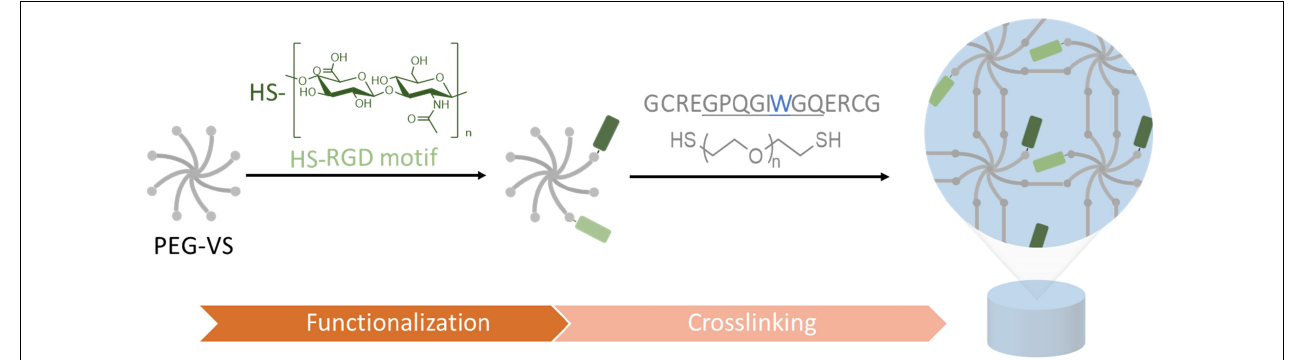
Figure 1 | Schematic illustration of PEG/GAG hydrogel formation. Branched 8-arm poly (ethylene glycol) PEG with terminal vinyl sulfone groups (VS) is functionalized with end-thiolated GAGs and peptide binding motifs (e.g., RGD) via thiol-Michael addition reaction. Following this functionalization, PEG macromolecules are crosslinked with a PEG-dithiol linker or matrix-metalloprotease (MMP)-cleavable di-cysteine peptide. The peptide linker sequence is derived from collagen with a single amino acid exchange from A to W (blue) for a higher enzyme affinity and enhanced degradability (cleavage site underlined).